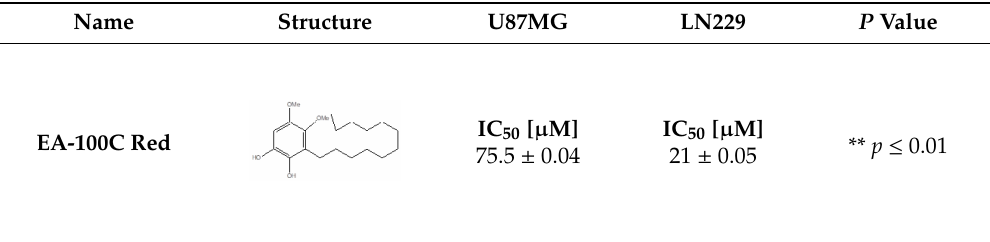
Table 1. IC 50 of EA100C Red on GBM